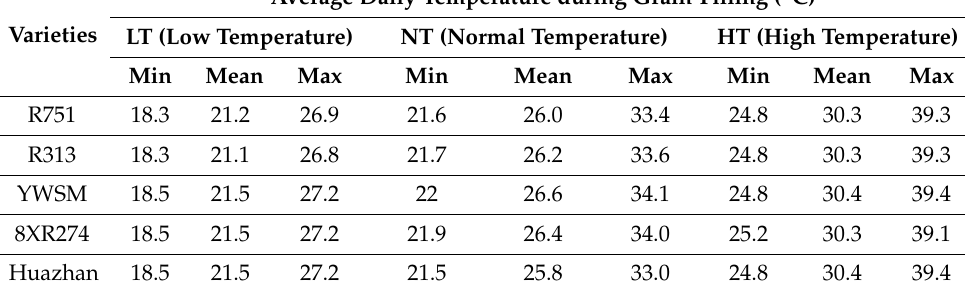
Table 1. Average daily temperature in the